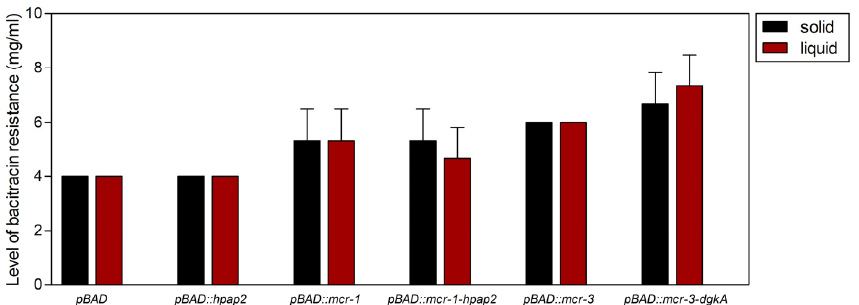
Figure 6. Level of bacitracin resistance from mcr-1–hpap2 and mcr-3–dgkA gene constructs. XL1-Blue MRF’ cells carrying the different recombinant plasmids were grown, induced with 0.2% arabinose, and spotted on Mueller–Hinton agar plates or liquid medium containing 0.02% arabinose supplemented with bacitracin at various levels, following the protocol described in Section 4. pBAD corresponds to XL1-Blue MRF’ cells carrying intact pBAD vector.